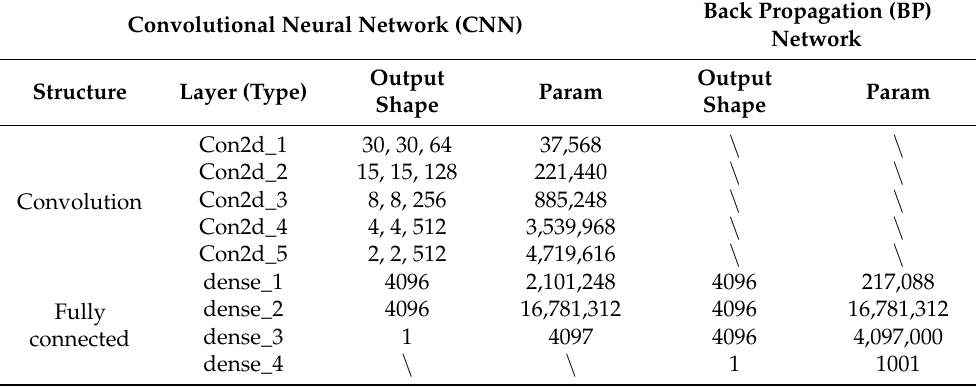
Table 9. Configuration information and training